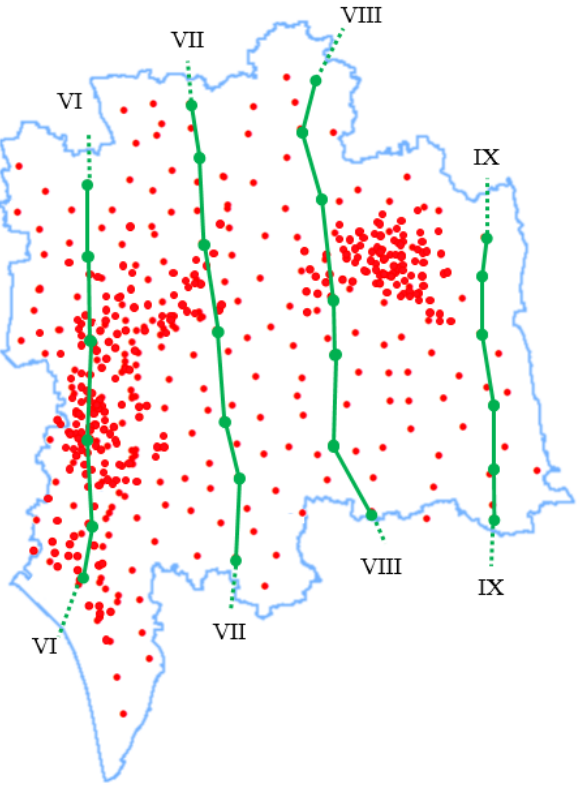
Figure 12. Borehole locations and lines connecting boreholes along south–north geological pro- files.